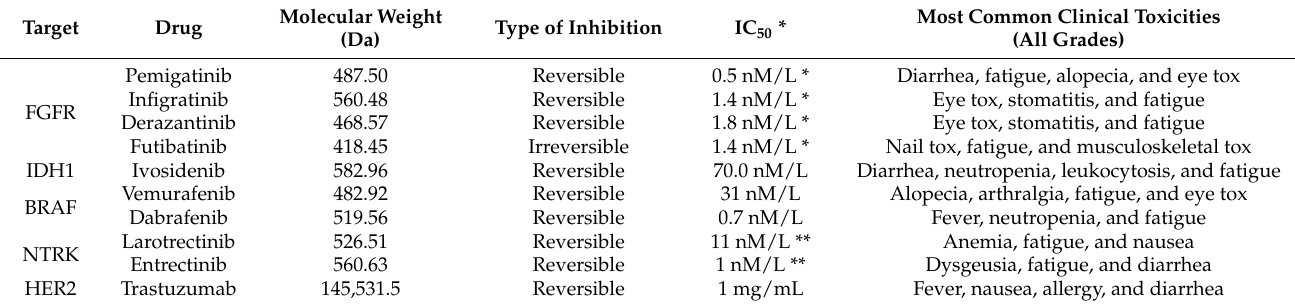
Table 3. Molecular and clinical characteristics of the target-based drugs used in CCA.